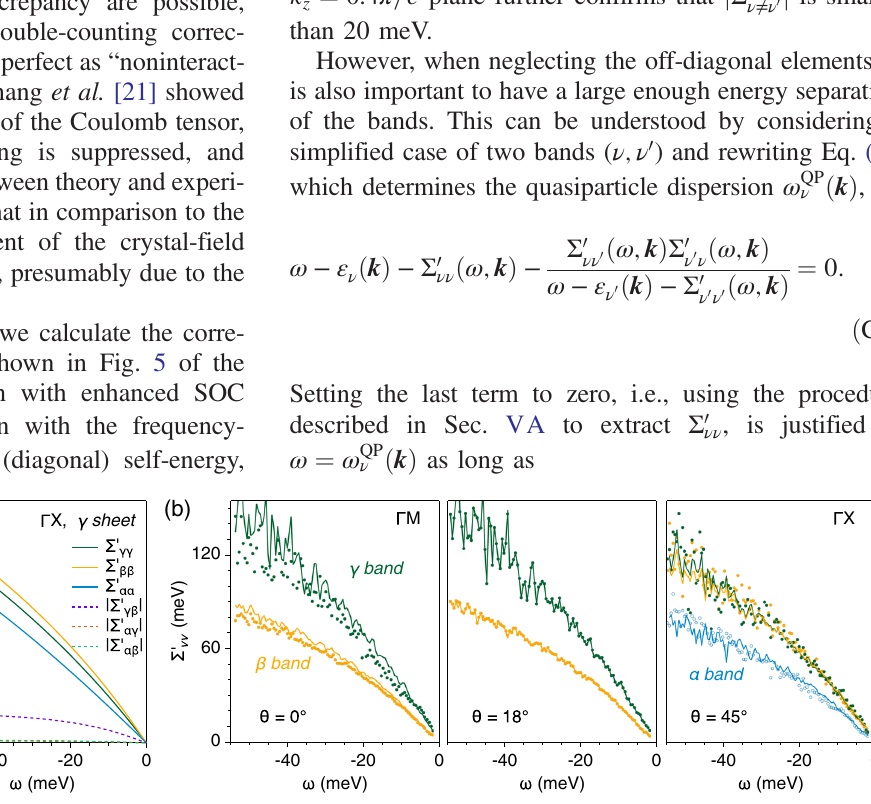
ð ω ; k Þ calculated with Eq. (12) using the DMFT 0 ω ; θ ¼ 18 ° Þ (Sec. V B) transformed to m ð